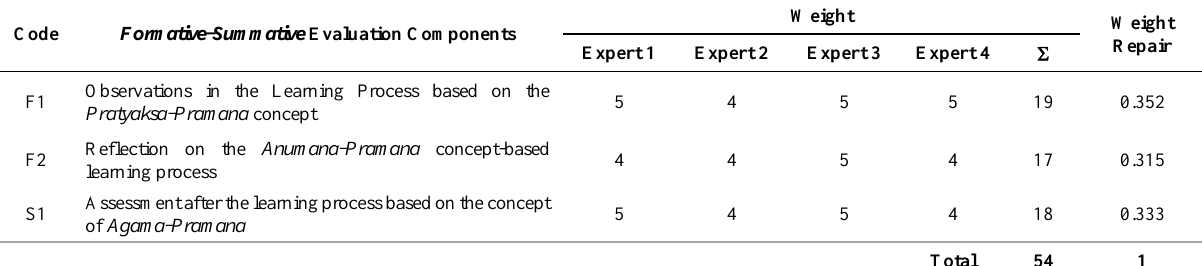
Table 4. Weights from Experts for Each Tri Pramana -Based Formative-Summative Evaluation Standard